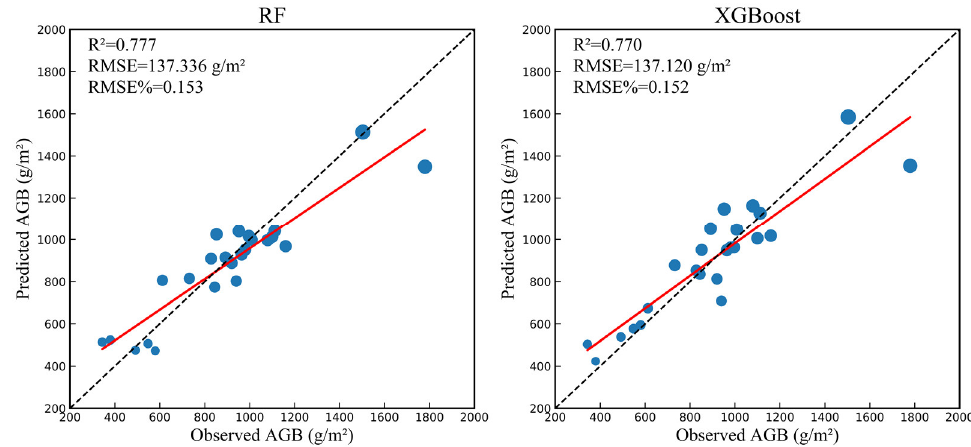
Figure 7. Observed vs. predicted AGB values in the Shengjin Lake wetland using the RF and XGBoost model in testing data set after five-fold cross-validation.